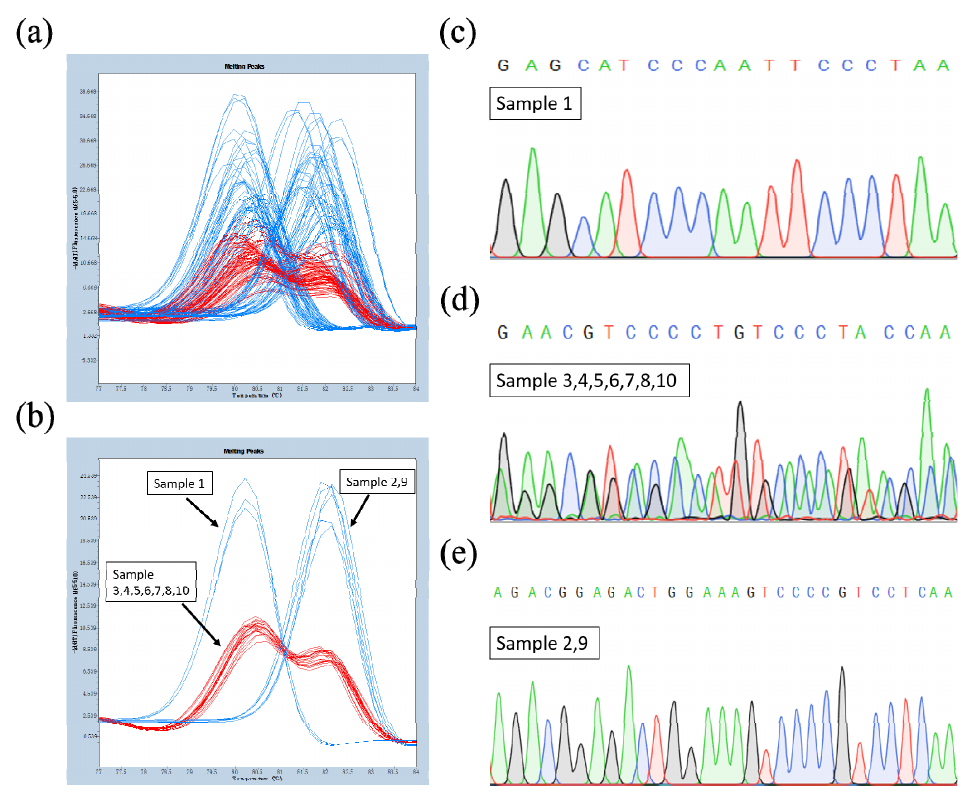
Figure 6. HRM curve peak plots and nucleotide sequences diagram of mutation site in F 2 individuals. ( a ) HRM curve peak plots for the 200 individual plants from F 2 hybrid population.( b ) Ten individual strain HRM curve peak plots for the hybrid population. ( c ) Sequencing peak plot of the mutation homozygous (with 11-nucleotides) GmBADH2 in the hybrid population. ( d ) Sequencing peak plot of the heterozygous genotypes of GmBADH2 in the hybrid population. ( e ) Sequencing peak plot of the non-mutation homozygous (without 11-nucleotide deletion) GmBADH2 in the hybrid population.